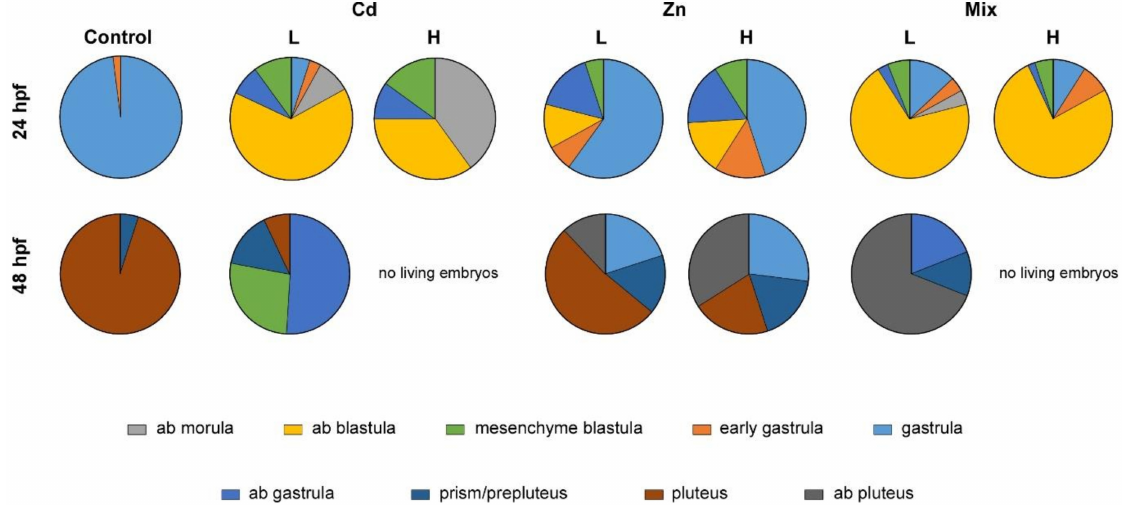
Figure 2. Embryo morphological abnormalities at 24 and 48 hpf and percentages in response to the different treatments (Cd, Zn and Mix of them) experienced by parentals. Data corresponding to embryos from means of three experiments are shown; SD were lower than 5%. L: low concentration; H: high concentration; Ab: